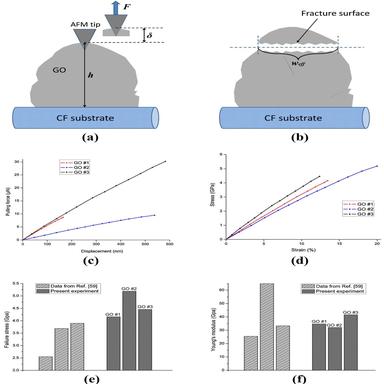
(a-b) Pulling out of GO from CF surface (the figure is not into scale): (a) Schematic of in situ nanomechanical pulling out test and the definition of height h, force F, and displacement δ (b) Definition of the effective contact width weff; (c-d) Experimental (c) force-displacement (d) stress-strain curves for three samples; (e-f) Comparison of (e) failure strength (f) Young's modulus obtained from the present experiment and available literature.